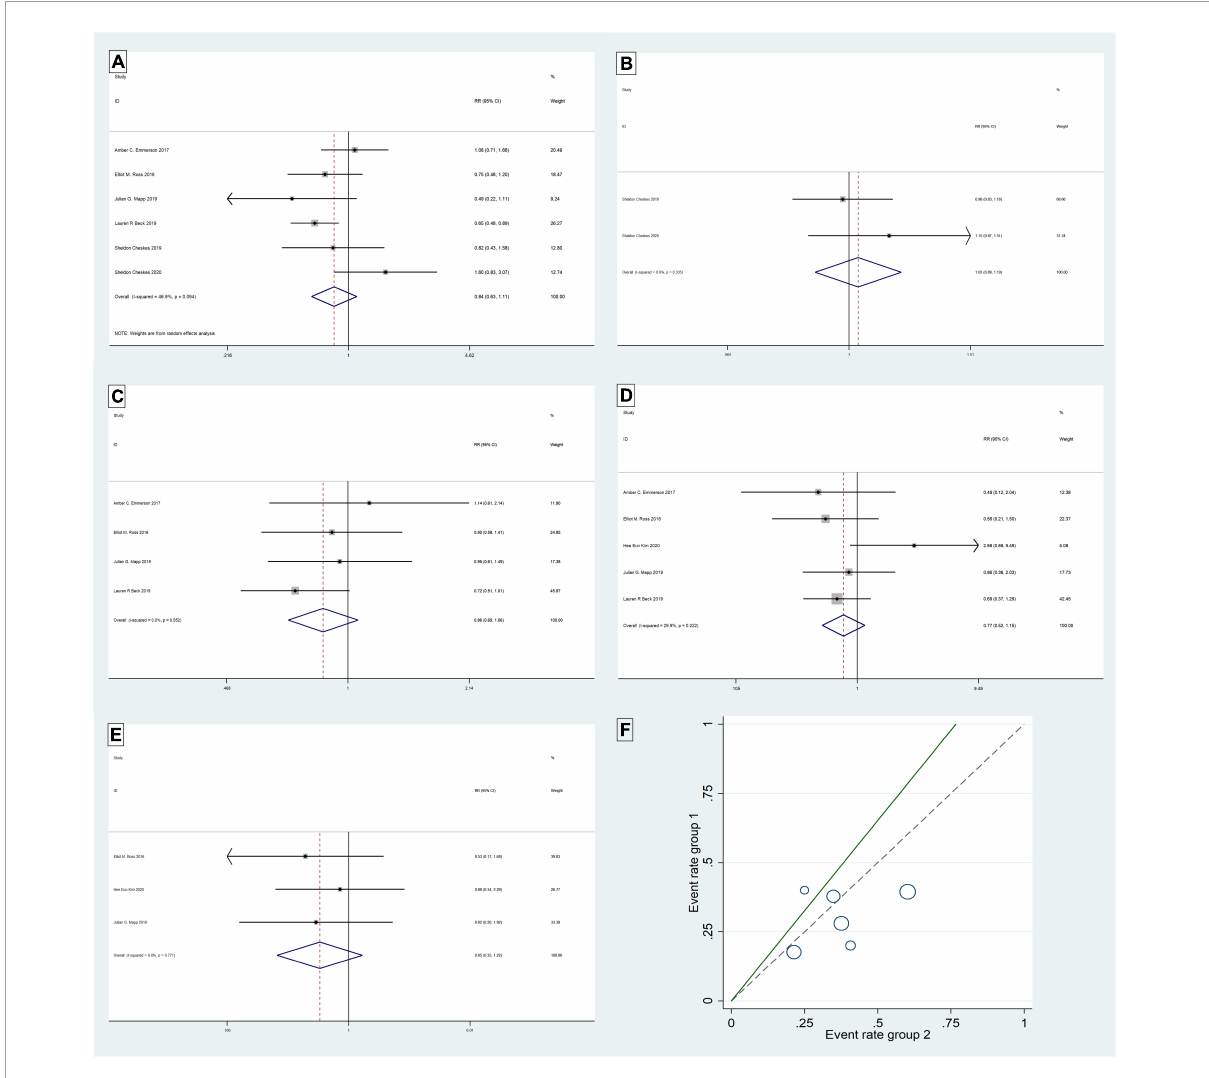
FIGURE2 Return of spontaneous circulation: Forest plot (A) ; L’ Abbe Plot (F) . Termination of refractory ventricular fibrillation: Frest plot (B) . Survival to hospital admission: Forest plot (C) . Survival to hospital discharge: Forest plot (D) . Good neurologic outcome: Forest plot (E)